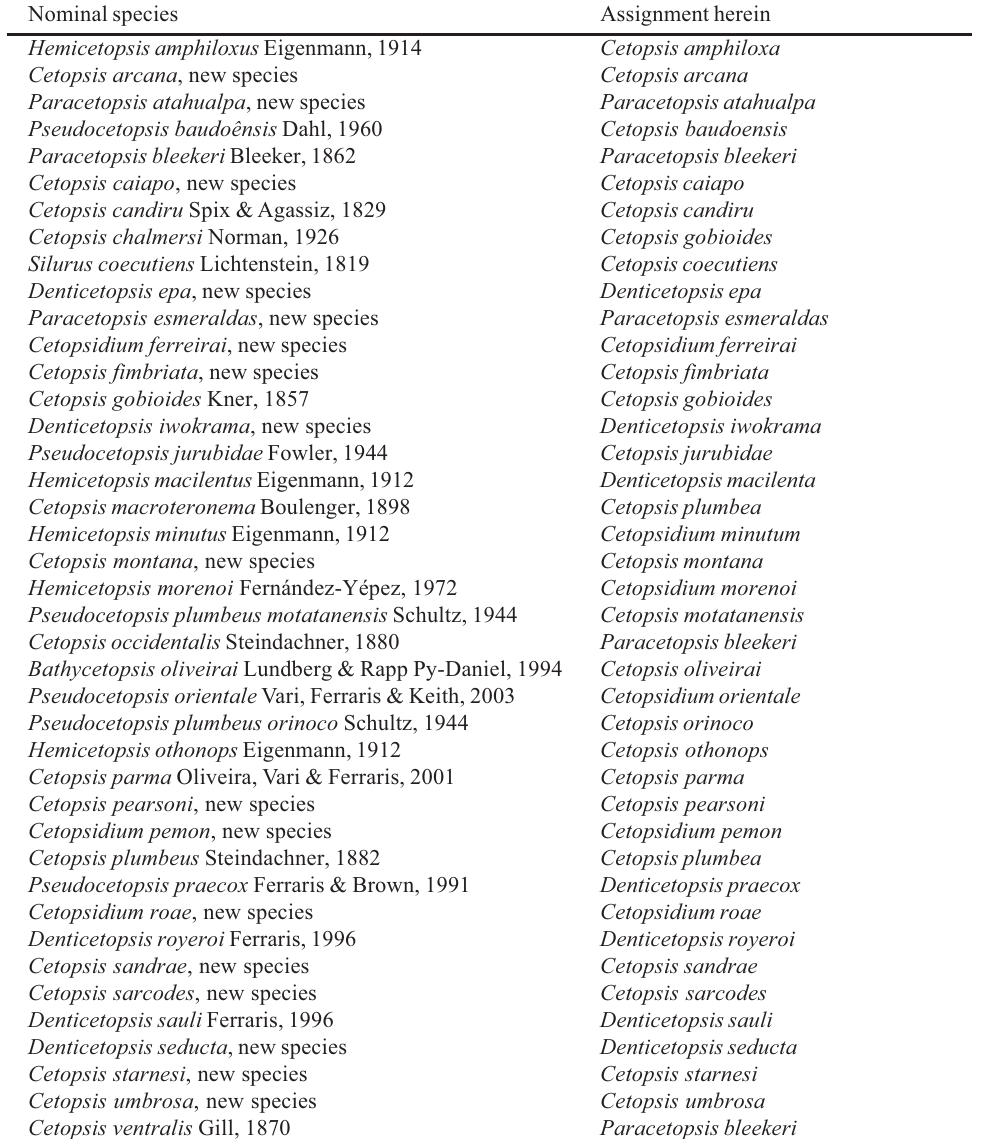
Table 1 . Nominal species assigned to the subfamily Cetopsinae in this study and the recognized equivalent species according to the results of this analysis. Nominal species are cited as in the original description and are arranged alphabetically by specific or subspecific